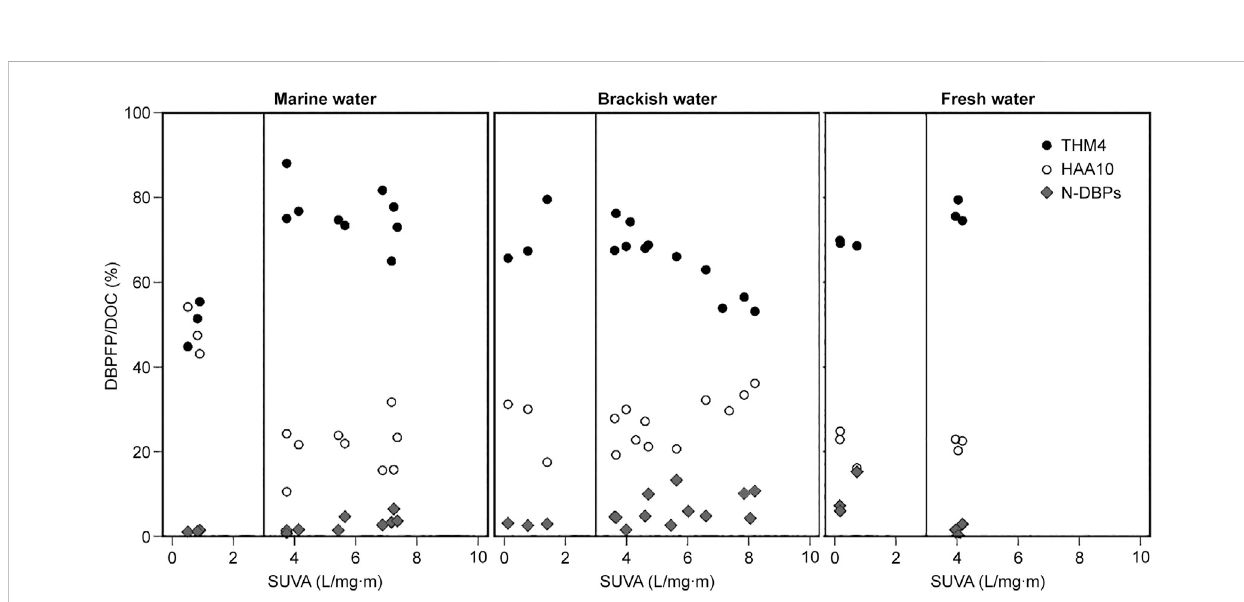
Relationship of the DBPs/DOC ratio relative to the SUVA values at each salinity